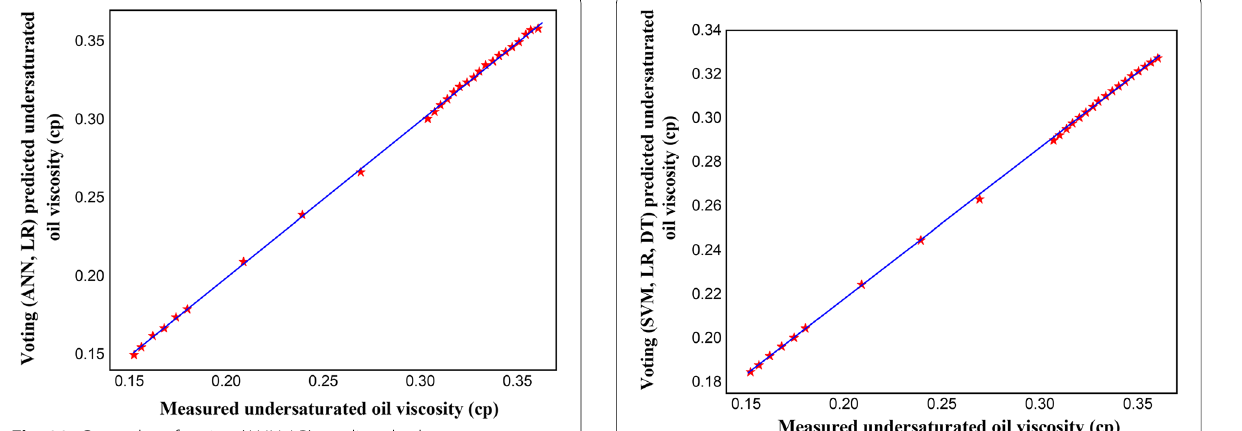
Fig. 22 Cross plot of voting (ANN, LR) predicted values versus measured values